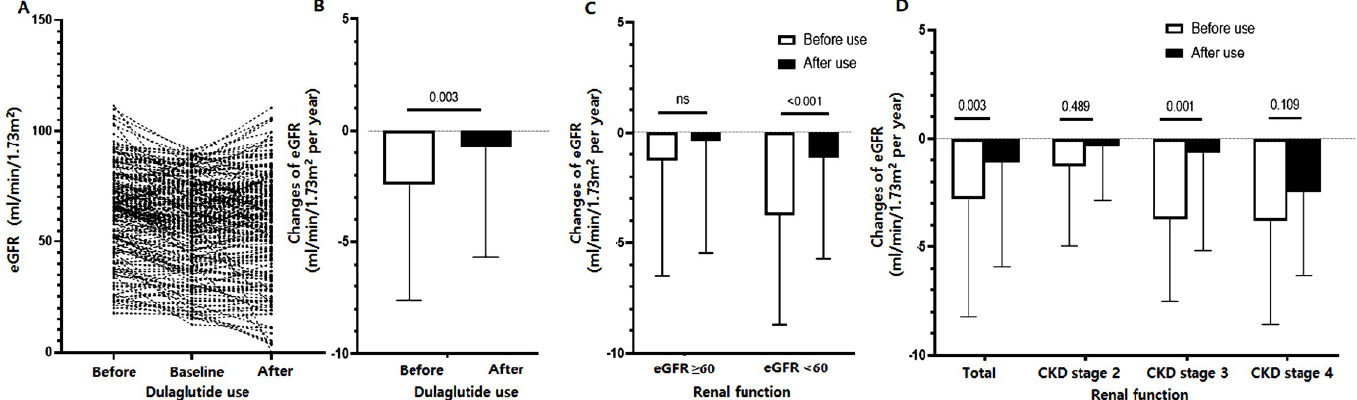
Fig 2. eGFR values and mean eGFR change after the use of dulaglutide. (A, B) The use of dulaglutide was associated with a significantly less decline of eGFR (paired t- test, P = 0.003). (C, D) The reduced decline in eGFR was more clearly observed in patients with moderate-to-severe CKD.